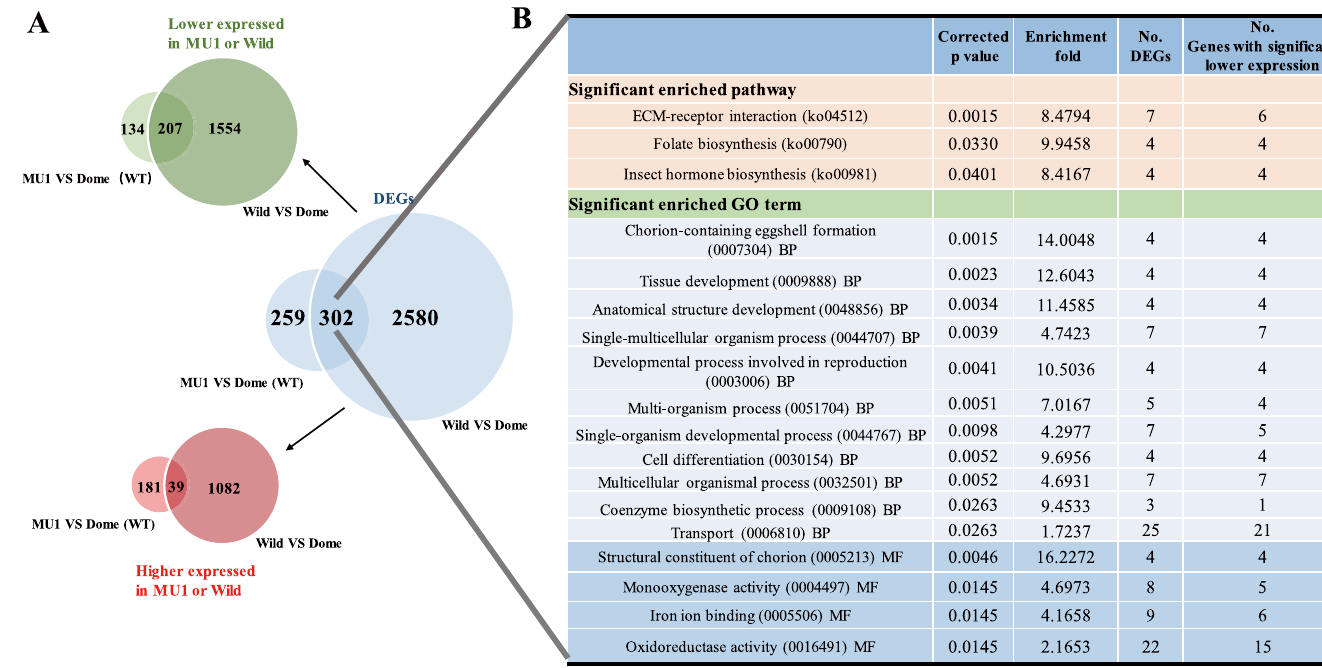
Fig 4. Differential expressed genes (DEGs) and functional enrichment analysis of the common genes from DEGs of two comparisons, i.e., from mutant VS the domestic silkwom wild type, and from the dometic and the wild silkworm. (A) Venn diagram of the DEGs between the wild type and the mutant, as well as domestic and wild silkworm ( Bombyx mandarina ). The blue Venn diagram represents the total DEGs, The green Venn diagram and the red Venn diagram represent significantly lower and higher expressed, respectively. (B) Functional enrichment analysis of common genes shared in the two sets of DEGs. Corrected p -value: p -value in hypergeometric test after FDR correction. All non-redundant terms that had corrected p -value < 0.05 are shown.